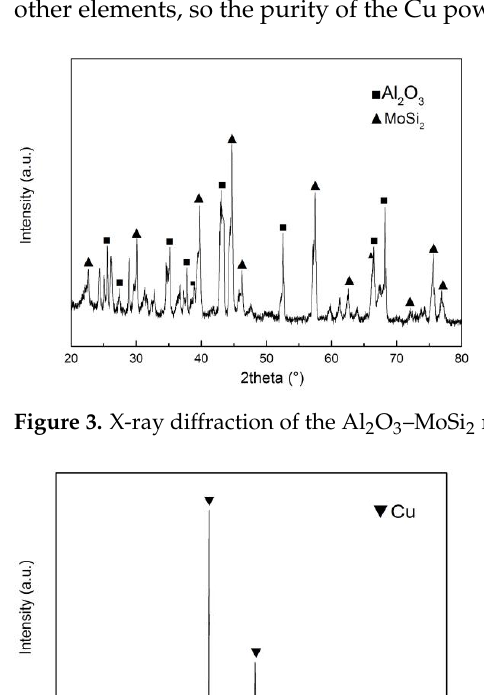
Figure 5. X-ray diffraction of the Al 2 O 3 –MoSi 2 /Cu composite coating surface: ( a ) T = 25 °C ( b ) T = 700 °C.